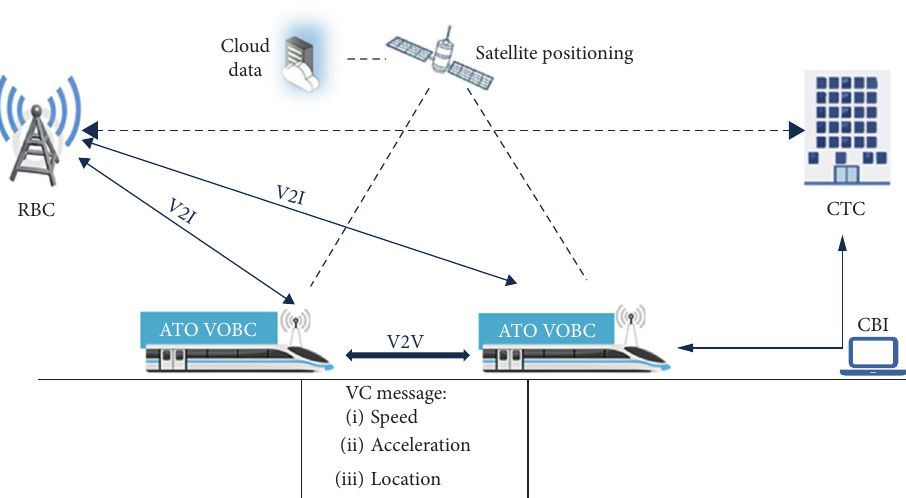
Figure 2: A potential system architecture of VC in the